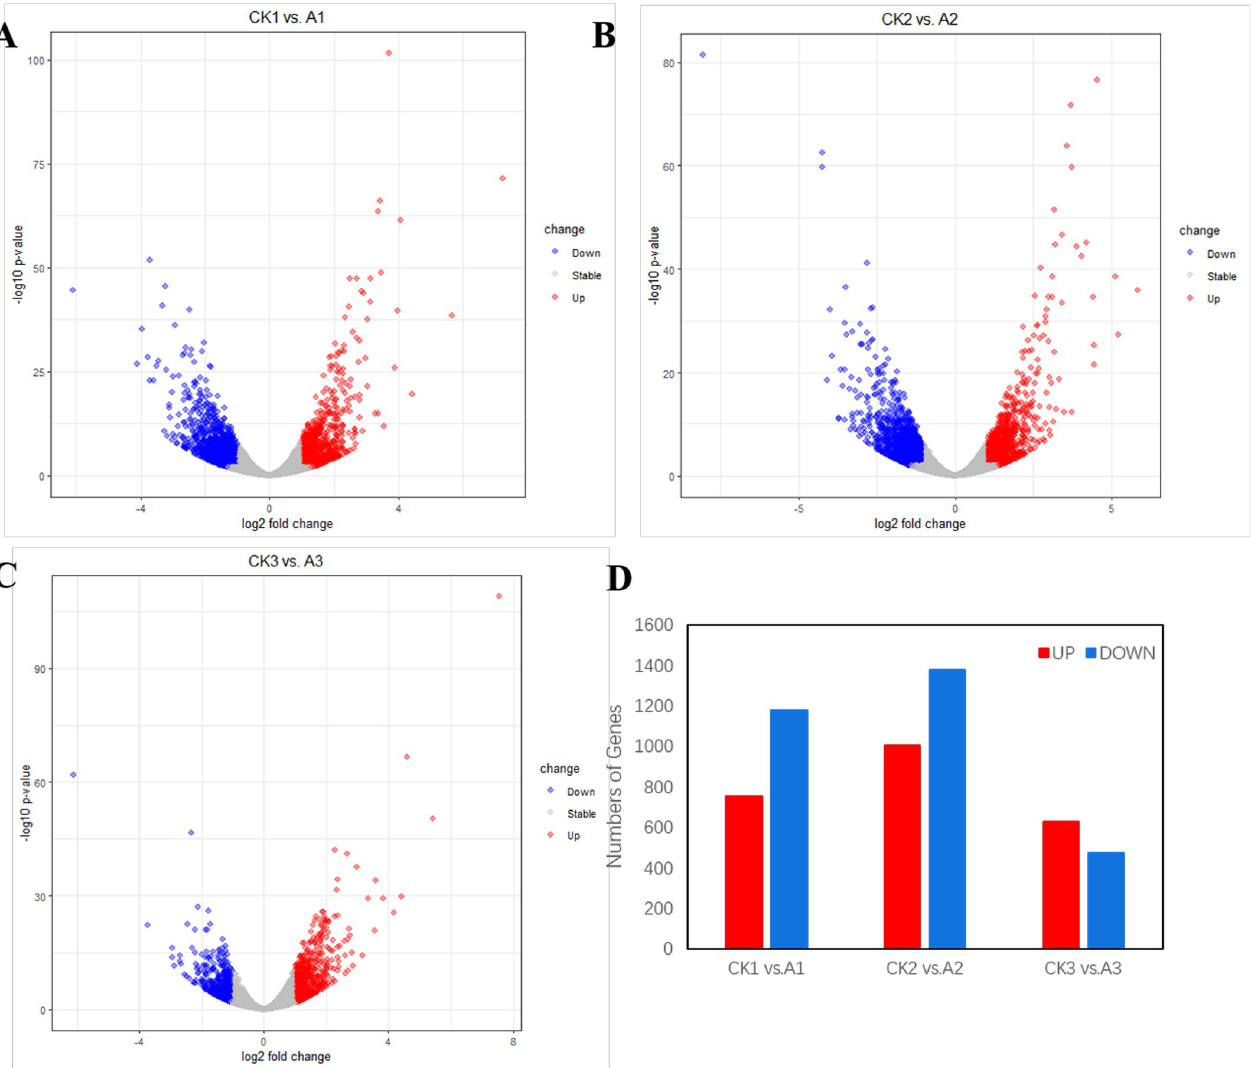
Fig 2. Expression profiles of mRNAs in A1, A2 and A3 compared with control groups. The Vocalo plot of (A), (B), (C) represent the expression of all genes in A1 vs CK1, A2 vs CK2, and A3 vs CK3. Different expressed genes were marked with red and blue, Red indicates upregulated genes, blue is down regulated. (D) Histogram of DEGs in A1 vs CK1, A2 vs CK2, and A3 vs